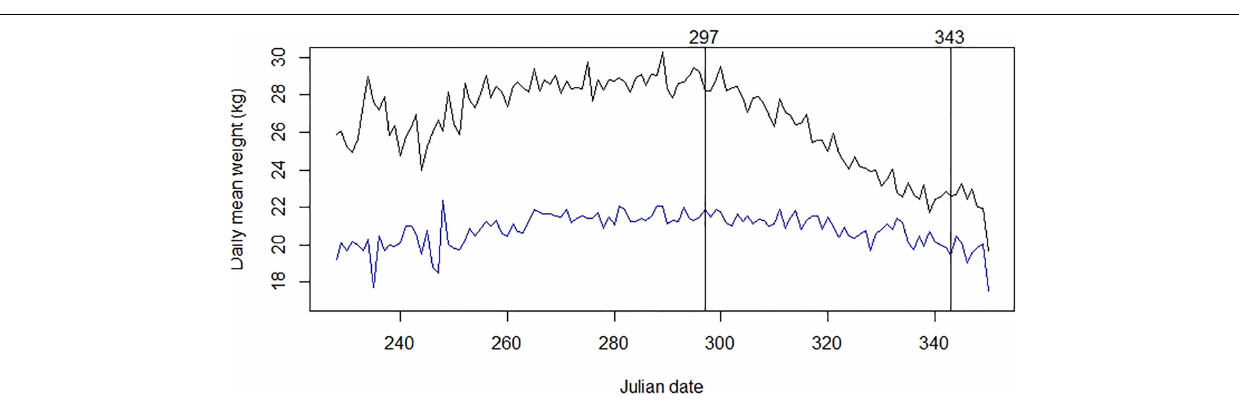
FIGURE 4 | Males (black) and females (blue) chamois average daily body mass and rut period (defined by the two labeled black lines). Table 1 provides details about sample size and origin of data. TABLE 2 | Changes (%) in standardized body mass of social mature male in three ungulate species. Species Changes in standardized body mass (%) Body mass SD Decline during the rut* A month after the end of the rut 2 months after the end of the rut Pre-rut Post-rut Roe deer Red